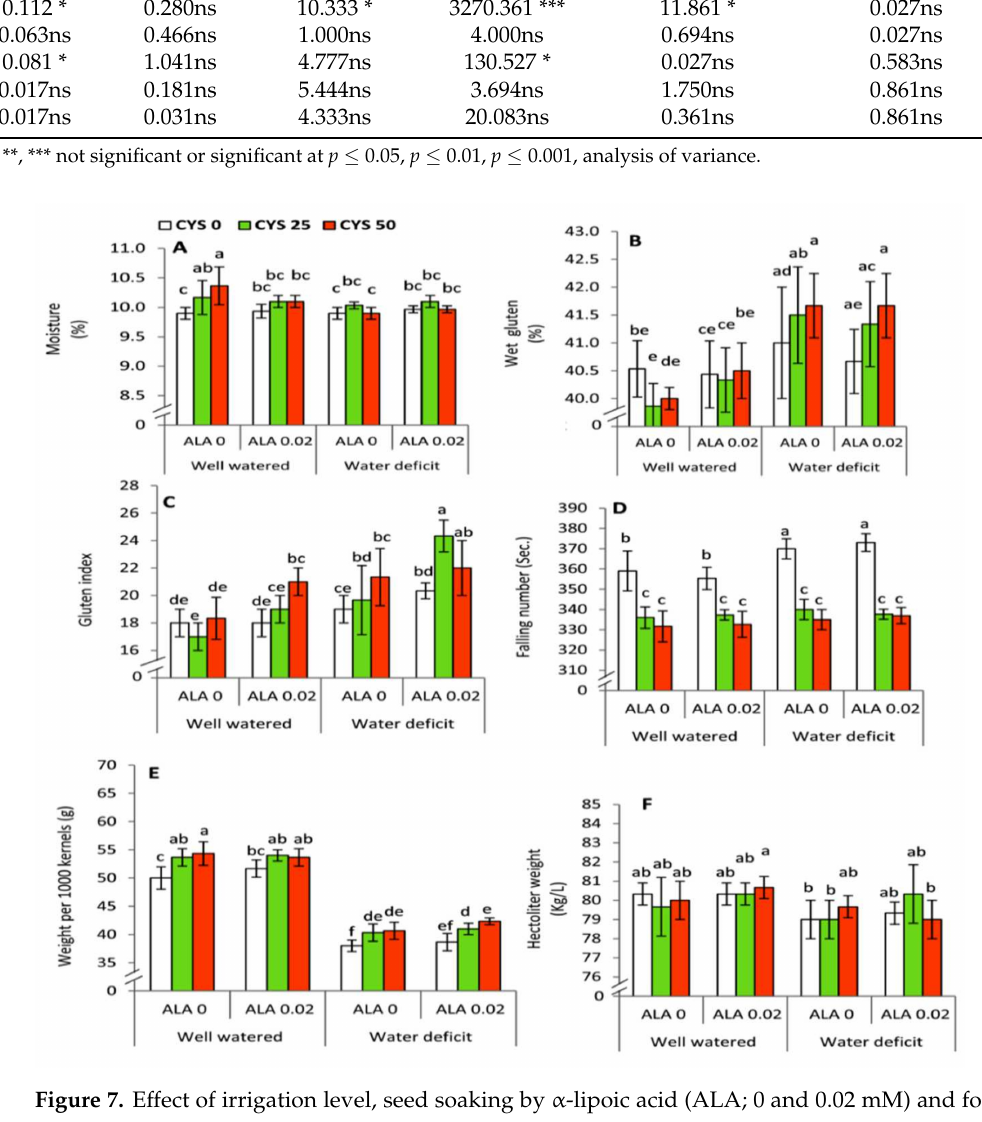
Figure 7. Effect of irrigation level, seed soaking by α -lipoic acid (ALA; 0 and 0.02 mM) and foliar application by cysteine (Cys; 0, 25 and 50 ppm) on the physical/chemical properties of wheat grains. ( A ) Moisture content, ( B ) Wet gluten, ( C ) Gluten index, ( D ) Falling number, ( E ) Weight per 1000 kernels, ( F ) Hectoliter weight. For each parameter, the mean values ± SD followed by a different letter are significantly different according to Tukey’s range test ( p ≤